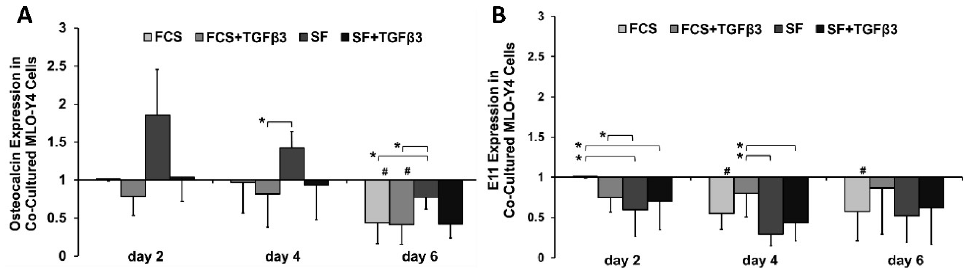
Figure 2. Fold-change in relative gene expression for ( A ) osteocalcin (CT: 18–23) and ( B ) E11 (CT: 19– 21) in 3D co-cultured MLO-Y4 osteocyte-like cells. Gene expression levels were normalized to